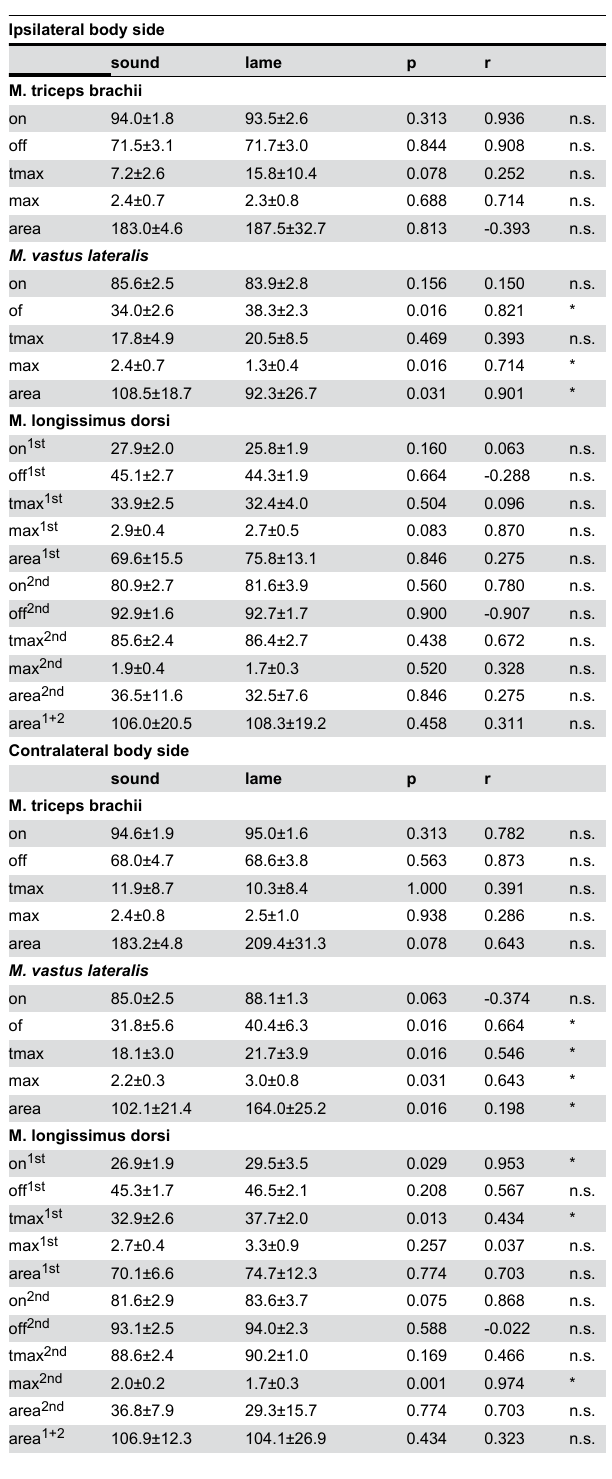
Table 1. EMG results for the muscles on the body side on which hindlimb lameness was induced (i.e., ipsilateral) and the body side opposite to the one on which hindlimb lameness was induced (i.e.,